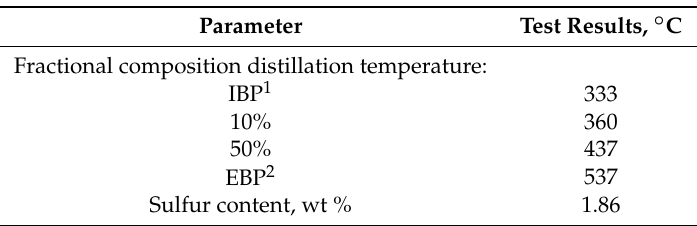
Table 4. Characteristics of nonhydrotreated VGO. Parameter Test Results, ◦ C Fractional composition distillation temperature: IBP